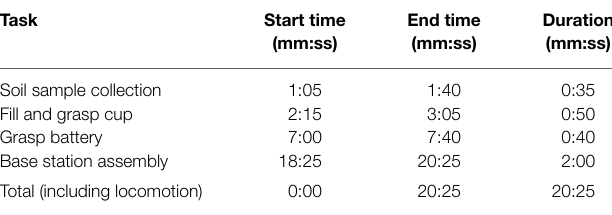
TABLE 1 | Timings of our run at the DLR SpaceBot Camp 2015 .